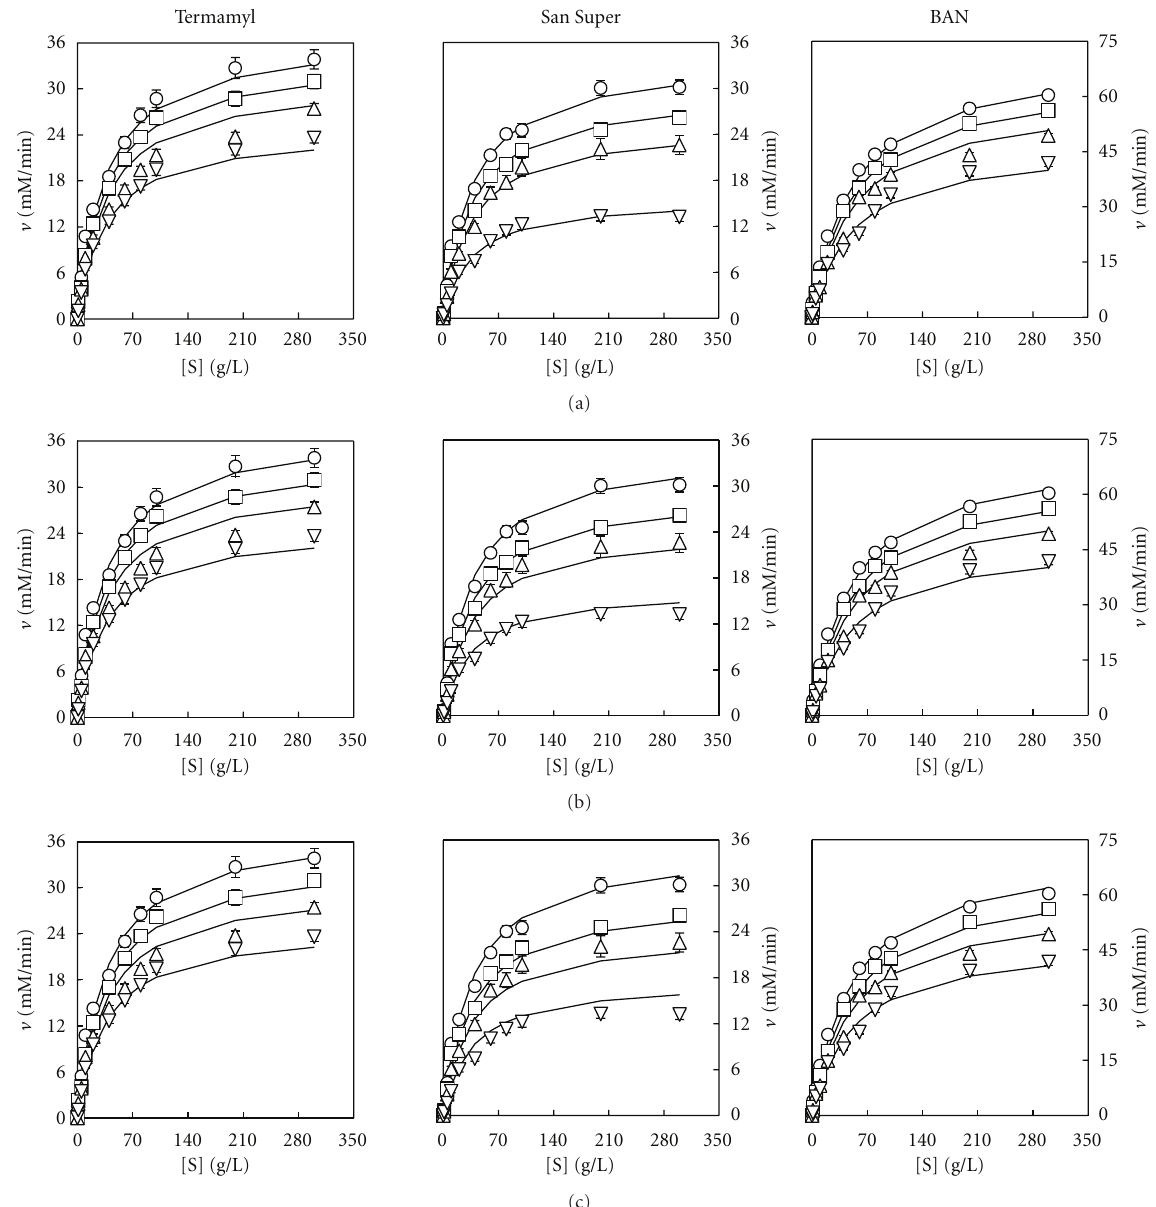
Figure 3: Changes in amylolytic activity ( v ) with the concentration of unaged starch (O) and starches [ S ] aged for 24 h ( (cid:2) ), 48h ( (cid:3) ), and 100 h ( ∇ ). The experimental points (as means ± standard deviations) are the amylolytic activity data showed in Figure 1(a) for each enzyme. The curves drawn through the experimental velocity data in (a), (b), and (c) were obtained according to the models (5), (6), and (7),